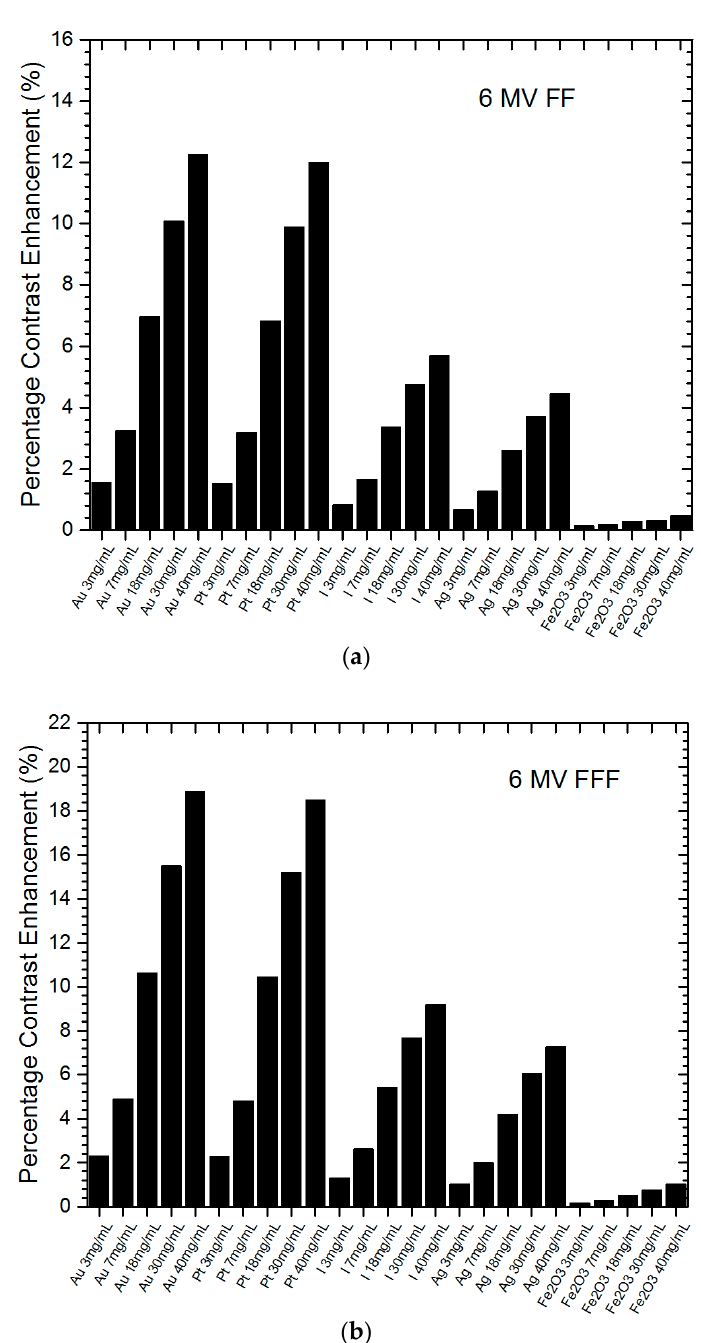
Figure 1. Relationships of percentage contrast enhancement for portal imaging with nanoparticle material and concentration using the 6 MV ( a ) flattening-filter (FF) and ( b ) flattening-filter-free (FFF) photon beams. Gold (Au), platinum (Pt), iodine (I), silver (Ag) and iron oxide (Fe 2 O 3 ) nanoparticles (NP) with concentrations equal to 3, 7, 18, 30 and 40 mg / mL were used. The percentage contrast enhancement was calculated as the percentage of increase of imaging contrast ratio when NP were added to the tumour.